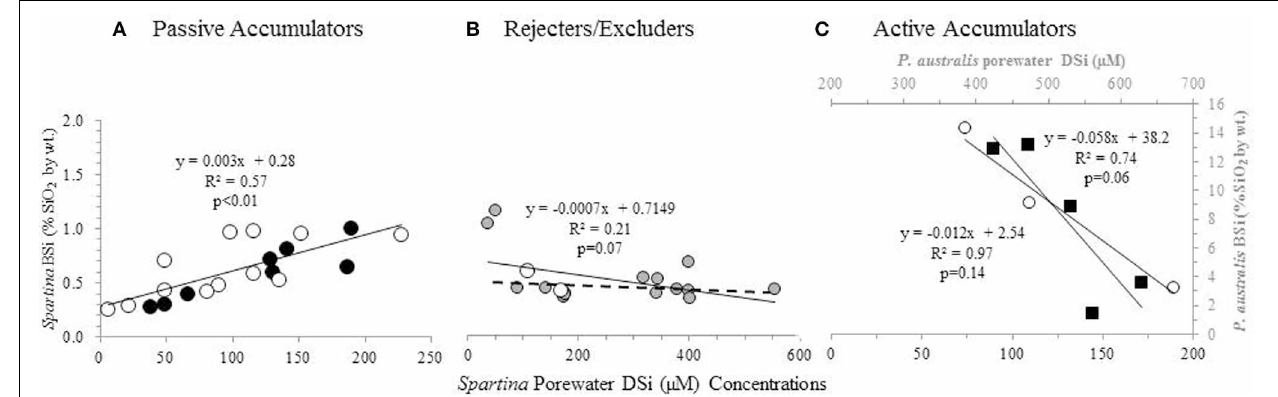
FIGURE 3 | BSi concentration in aboveground biomass as a function of porewater DSi concentrations. S. patens (black circles), S. anglica (filled gray circles), and S. alterniflora (open white circles), P. australis (black squares). Dashed line in (B) indicates the regression ignoring the two S. anglica outliers. Values in (A,C) represent average values from triplicate field measurements in top 20cm of sediment, with spring and